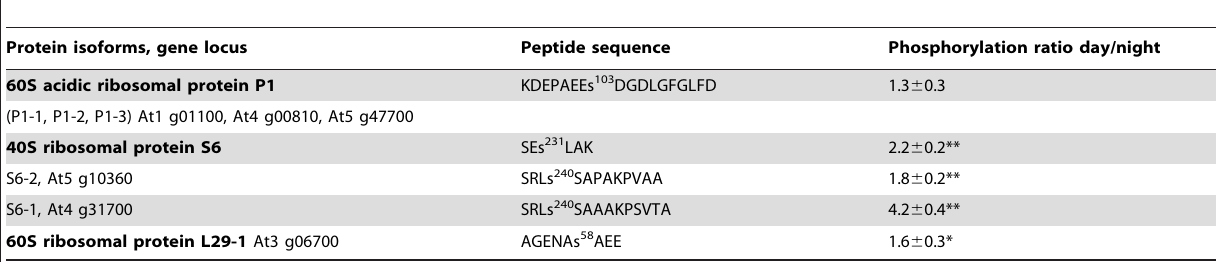
Table 2. Relative quantitation of ribosomal phosphopeptides isolated from leaves harvested at day or night.